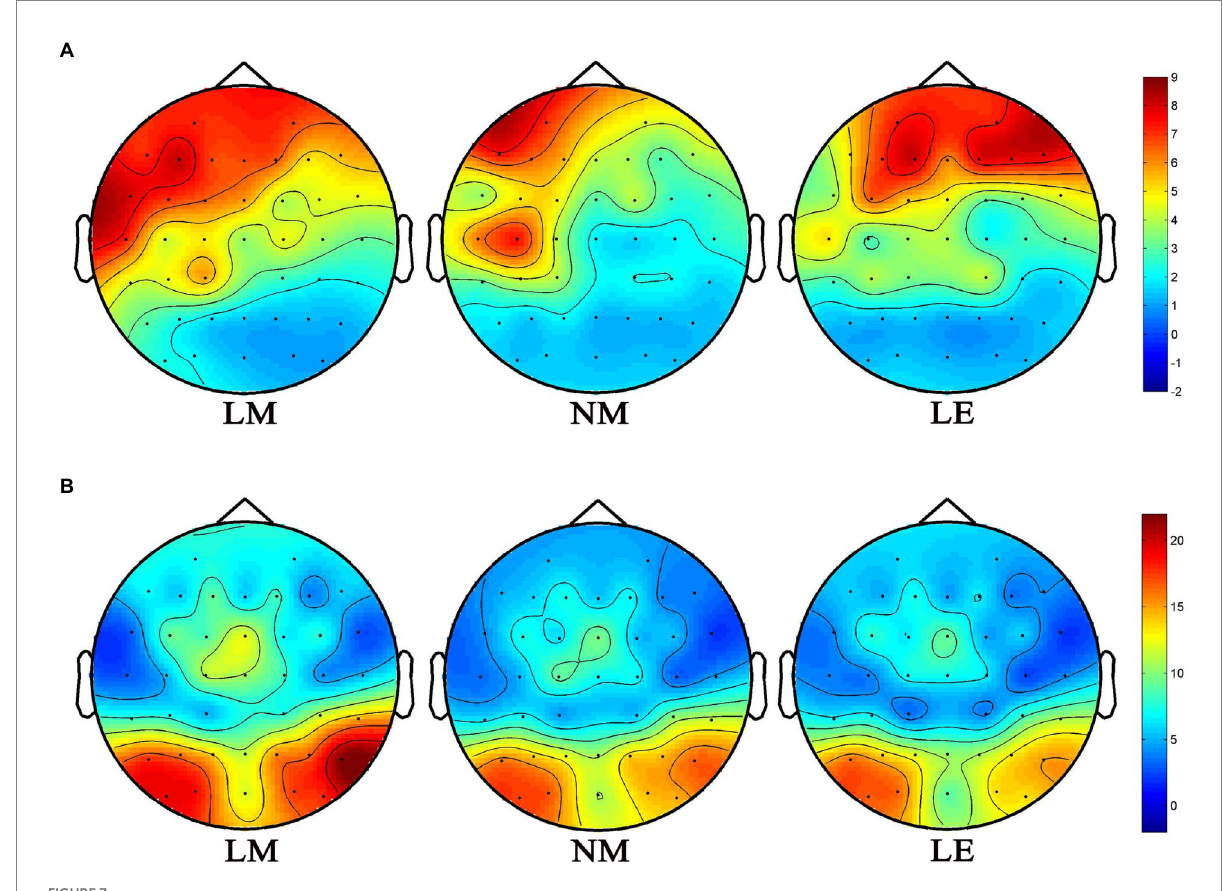
FIGURE 7 Topographies of power modulation. (A) delta; (B)